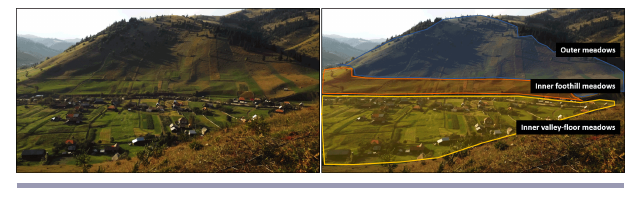
Fig. 4 . (a) Mowing kaláka (informal institution of collaborative, communal haymaking) was typical until